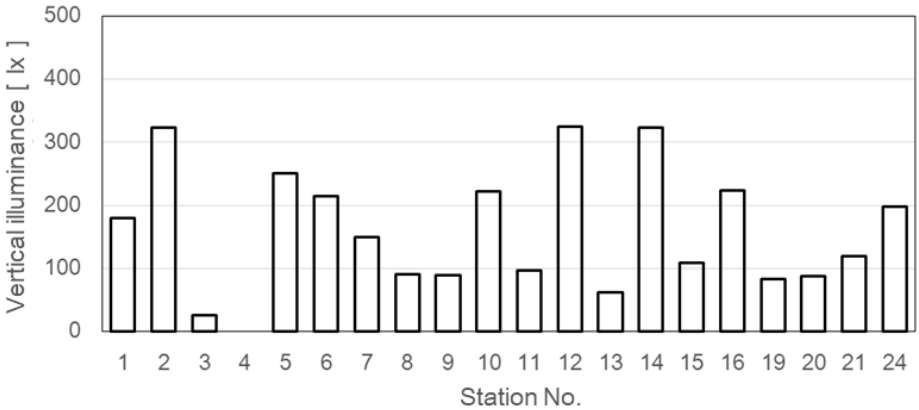
Figure 7. Vertical illuminance measurement result at the exit of stairs.